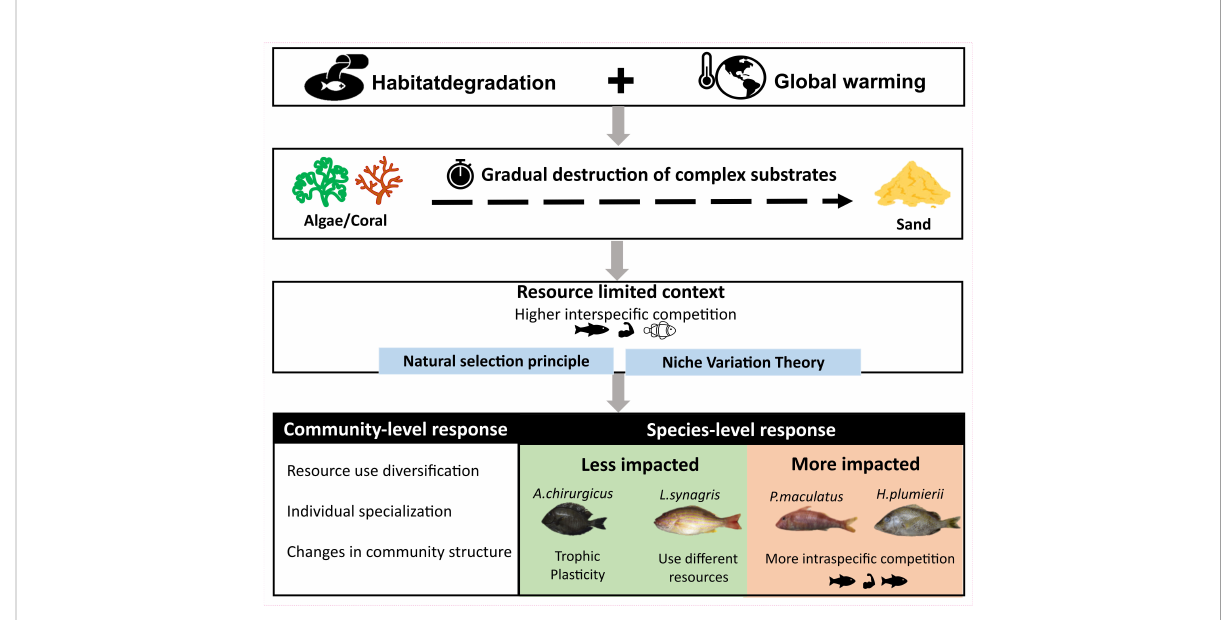
FIGURE 7 Possible responses of demersal fi sh to the combined threats of habitat degradation and global warming at community and species